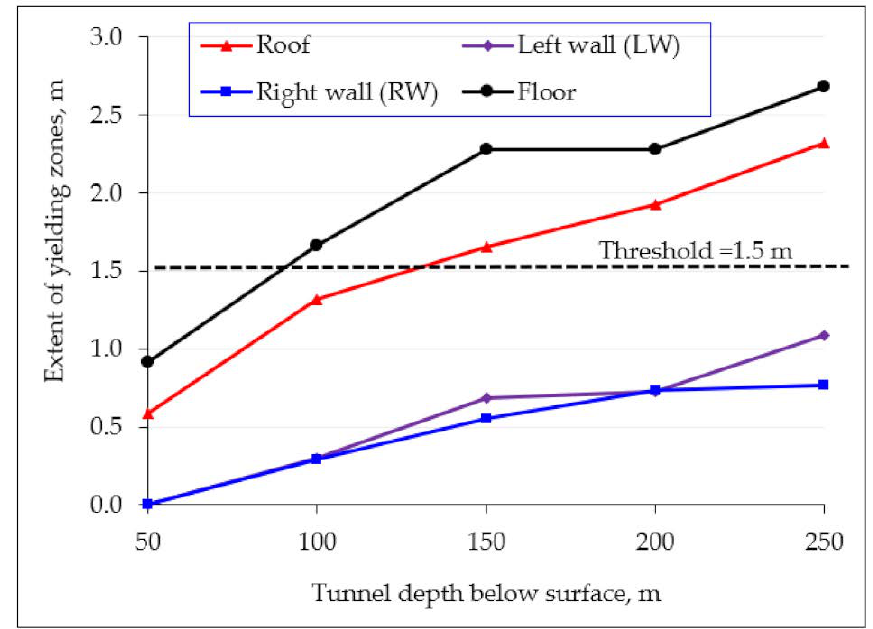
Figure 21. Depth of yielding zones into rock around tunnel at different depths below